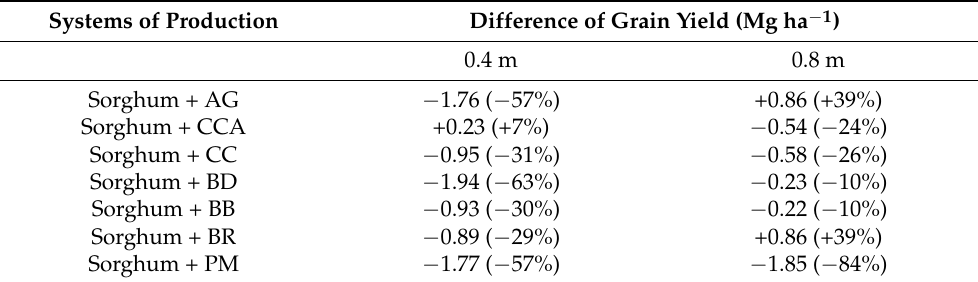
The difference is represented by the average yield in sole sorghum and sorghum with grasses (average). Table 3. Production of grains and grass dry matter (Mg ha − 1 ) in the systems of production with sorghum and grasses ( Andropogon gayanus —AG; Cenchrus ciliaris cv. Aridus—CCA; Cenchrus ciliaris cv. 131—CC; Brachiaria decumbens —BD; Brachiaria brizantha —BB; Brachiaria ruziziensis —BR; Panicum maximum —PM) in row spacings of 0.4 and 0.8 m in the Crop Years 1 and 2.